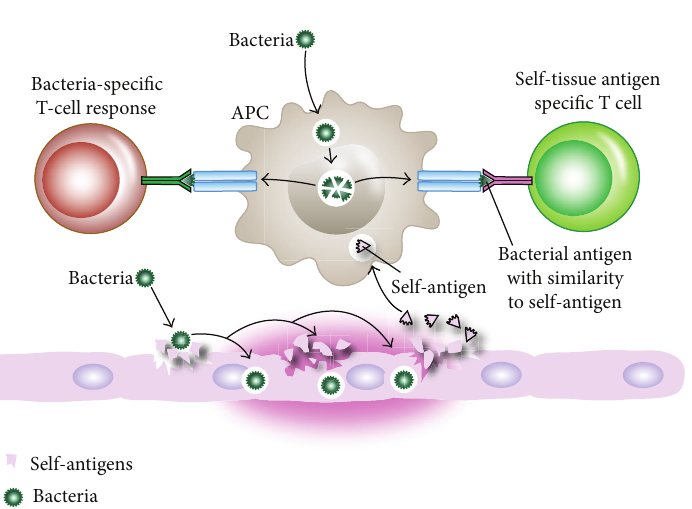
Figure 5: Mechanisms of infection-induced autoimmunity through molecular mimicry. Bacterial induction of self-tissue antigen release and simultaneous presentation of bacterial and self-tissue antigens to T cells; activated T cells can produce antibodies against both bacterial and self-tissue